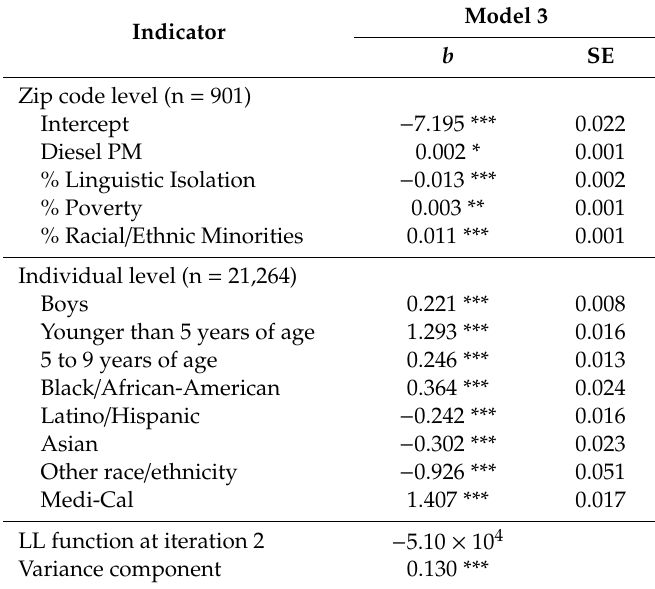
Table 4. Final model of rates of asthma hospitalizations estimated by hierarchical generalized nonlinear models by zip-code-level and individual-level indicators, 2010 2012, California.